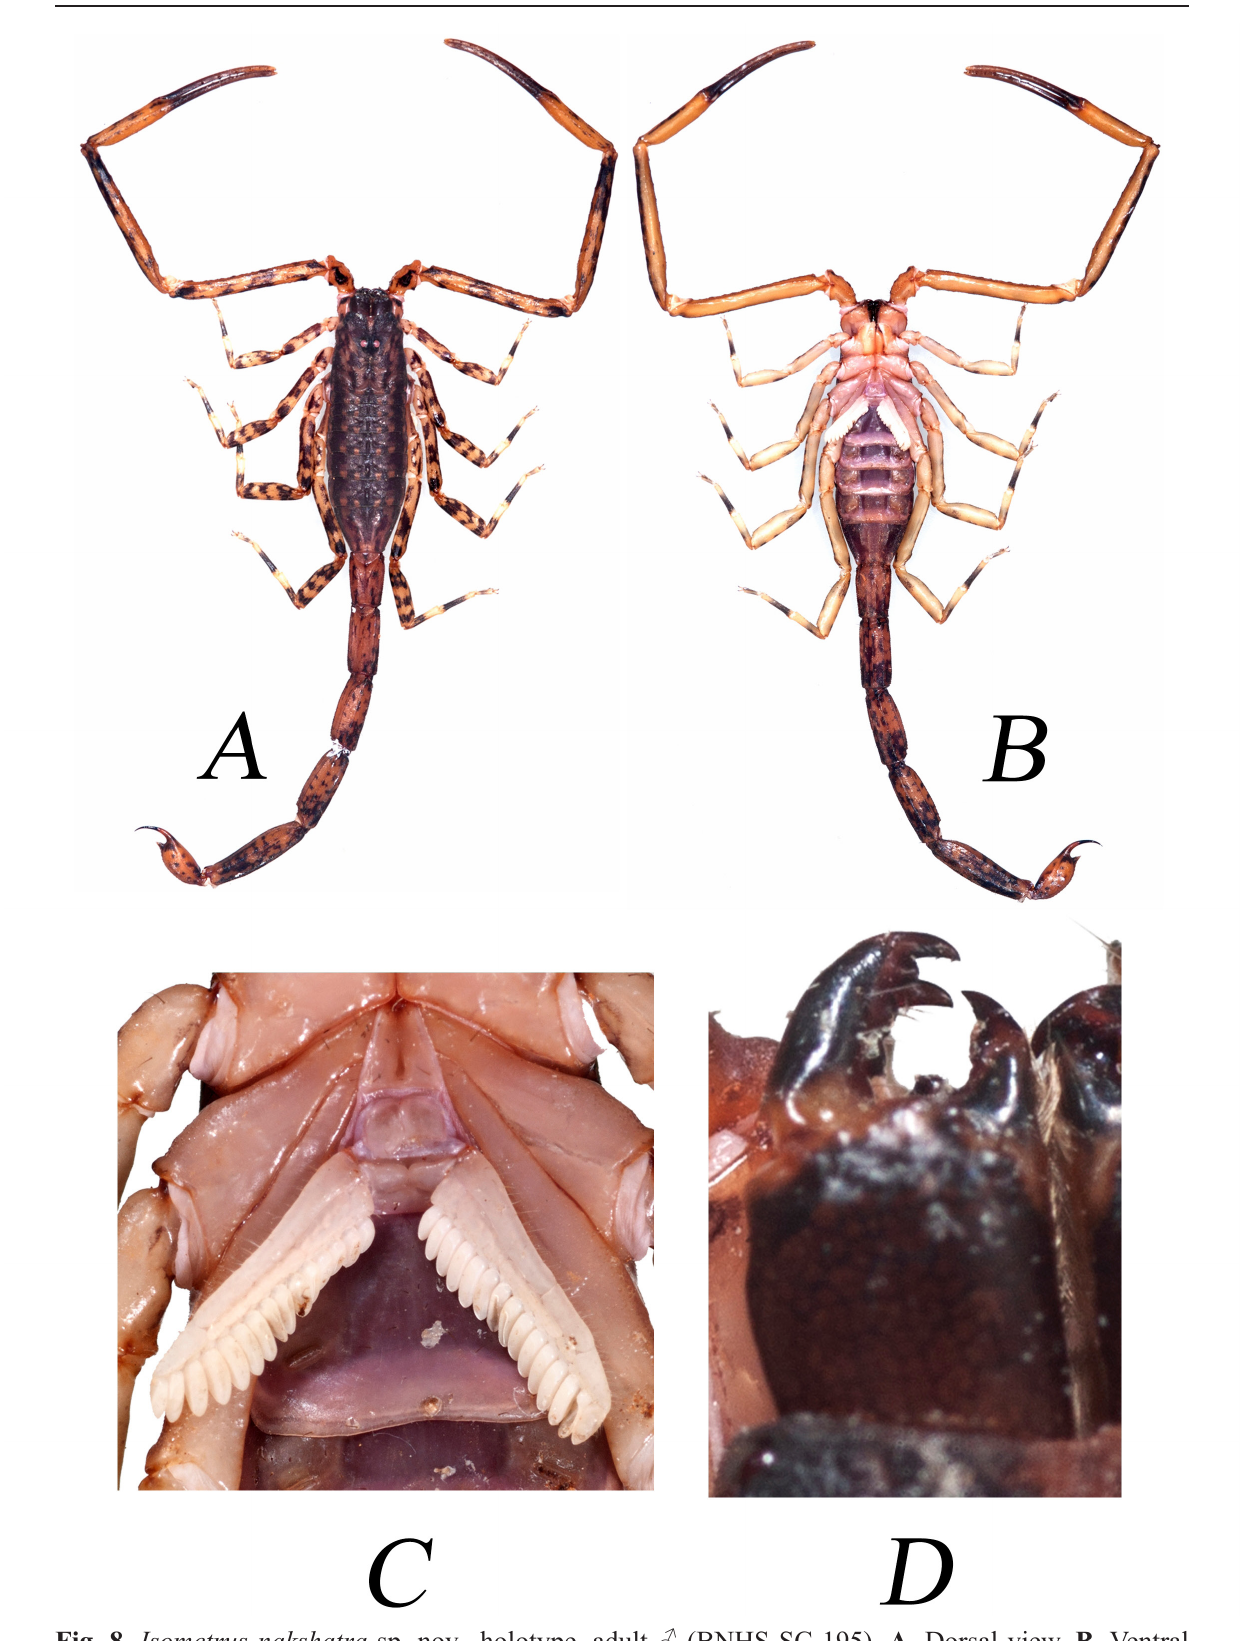
Fig. 8. Isometrus nakshatra sp. nov., holotype, adult ♂ (BNHS SC 195). A . Dorsal view. B . Ventral view. C . Sternopectinal area. D . Chelicera, dorsal